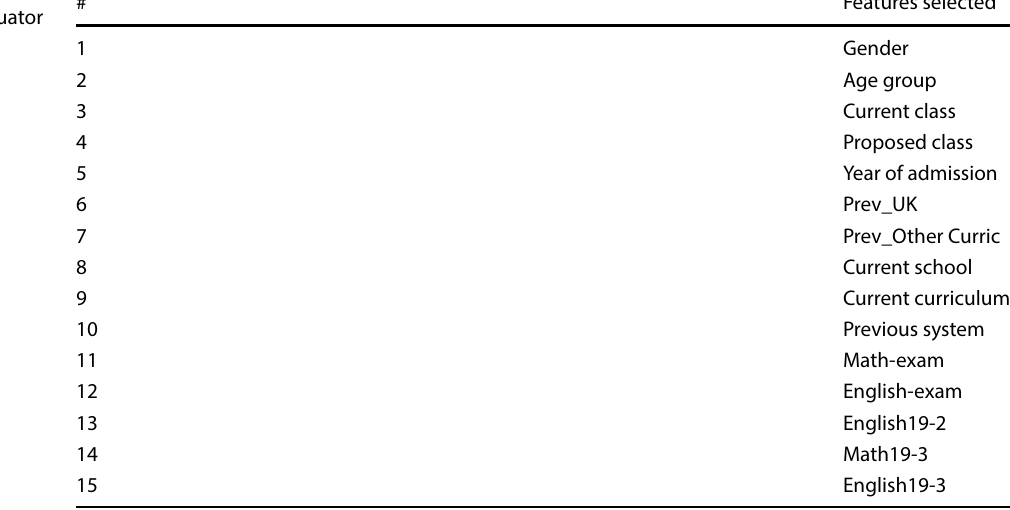
Table 4 Features selected using the Cfs subset evaluator and best first